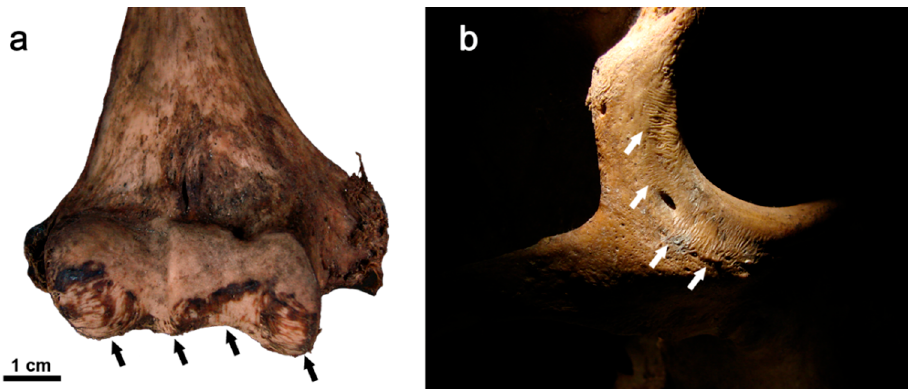
Figure 5. Rodent modifications on human bones in the form of parallel striations from a forensic casework (indicated by arrows). Rodent gnawing signs of post-mortem origin ( a ) on the distal epiphysis of a right humerus and ( b ) on infraorbital and lateral margins of the right zygomatic bone. Images courtesy of J. Viciano.